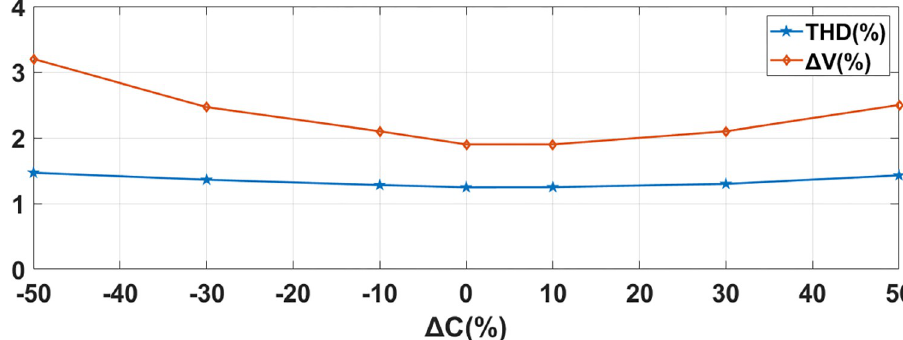
Fig 15. Sensitivity of proposed MPC controller to variations in capacitor value for AC-DC Converter.